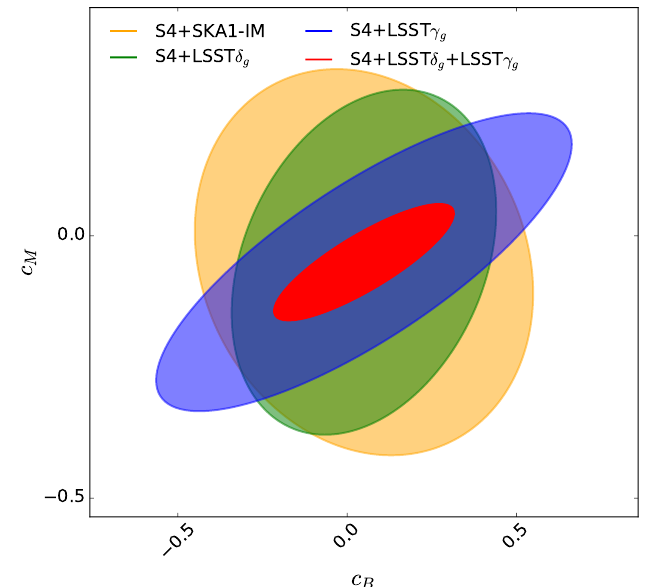
Figure 5. Sixty-eight percent (68%) confidence level contours on c M and c B obtained combining a stage IV CMB survey with the expected measurements of intensity mapping from SKAO (yellow), weak lensing (blue) and galaxy clustering (green) from LSST, and the combination of the latter two (red). Reprinted figure with permission from the authors of [39] by the American Physical